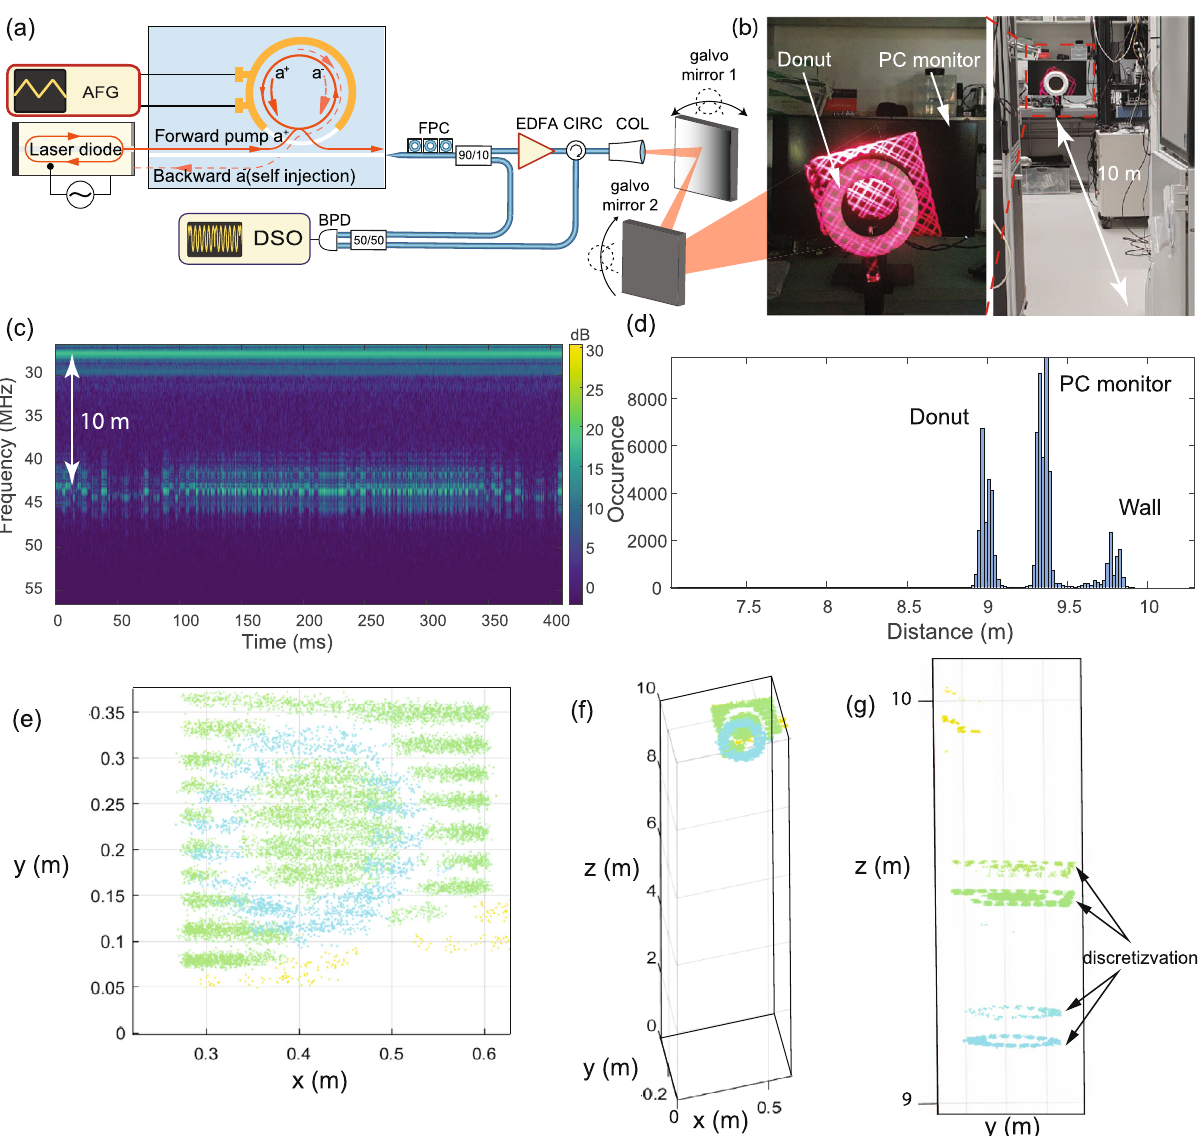
Fig. 4 Optical ranging using the frequency-agile, hybrid integrated laser. a Schematic of the setup for FMCW LiDAR measurement. A triangular ramp with 150 V peak-to-peak amplitude at 100 kHz rate is applied to the AlN piezoactuator providing a 1.2 GHz optical frequency excursion of the self-injection locked DFB laser. Beam steering is realised using a mechanical galvo scanner with two mirrors. b Photos of the target - a donut in front of a PC monitor. c Time-frequency plot for a signal from the target. d Histogram of distance distribution in the point cloud. e – g Point cloud of the target from different perspectives using a beam scanning pattern with 3 Hz vertical and 60 Hz horizontal triangular scanning frequencies. Point colours are based on distance. Donut corresponds to blue, PC monitor - green, wall -